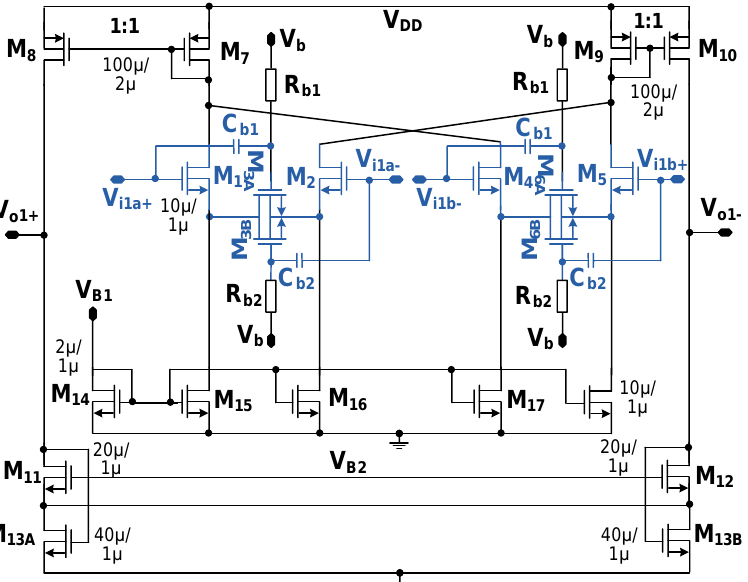
Figure 5. Schematic of the differential difference amplifier. Circuits for source degeneration is shown in blue color. (W/L) 3A,3B = (W/L) 6A,6B = 1 µ m/0.7 µ m. R b1,b2 is realized using a diode-connected transistor having a size of (W/L) = 0.9 µ m /0.7 µ m. C b1,b2 = 0.32 pF.